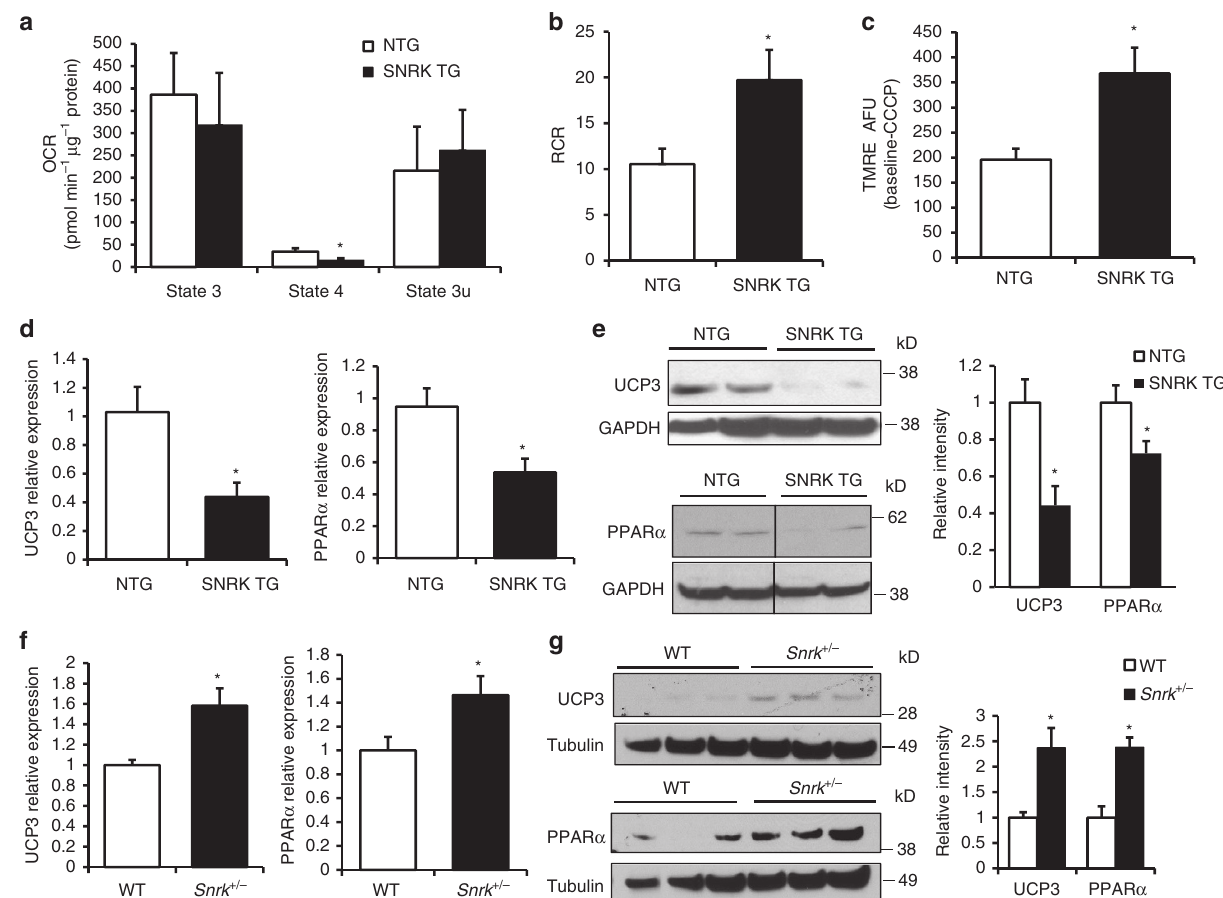
Figure 2 | SNRK increases mitochondrial coupling and decreases UCP3 and PPAR a . ( a ) Oxygen consumption rate (OCR) with pyruvate and malate in mitochondria from NTG and SNRK TG mouse hearts. State 3 respiration indicates oxygen consumption with ADP, state 4 indicates respiration with oligomycin, and state 3u indicates uncoupled respiration with CCCP. n ¼ 3. ( b ) Respiratory control ratio (RCR, state 3/state 4 respiration) in mitochondria from NTG and SNRK TG mouse hearts. ( c ) Mitochondrial membrane potential in cardiomyocytes from NTG and SNRK TG mice. AFU ¼ arbitrary fluorescence units. n ¼ 6. ( d ) UCP3 ( n ¼ 6) and PPAR a ( n ¼ 9) mRNA levels in NTG and SNRK TG mouse hearts. ( e ) UCP3 and PPAR a protein levels in NTG and SNRK TG mouse hearts. Graphs show summary of n ¼ 7–8 for UCP3 relative to GAPDH, and n ¼ 7–8 for PPAR a relative to tubulin. ( f ) UCP3 and PPAR a mRNA levels in WTand Snrk þ / (cid:2) mouse hearts. n ¼ 3. ( g ) UCP3 and PPAR a protein levels in WTand Snrk þ / (cid:2) mouse hearts, representative of